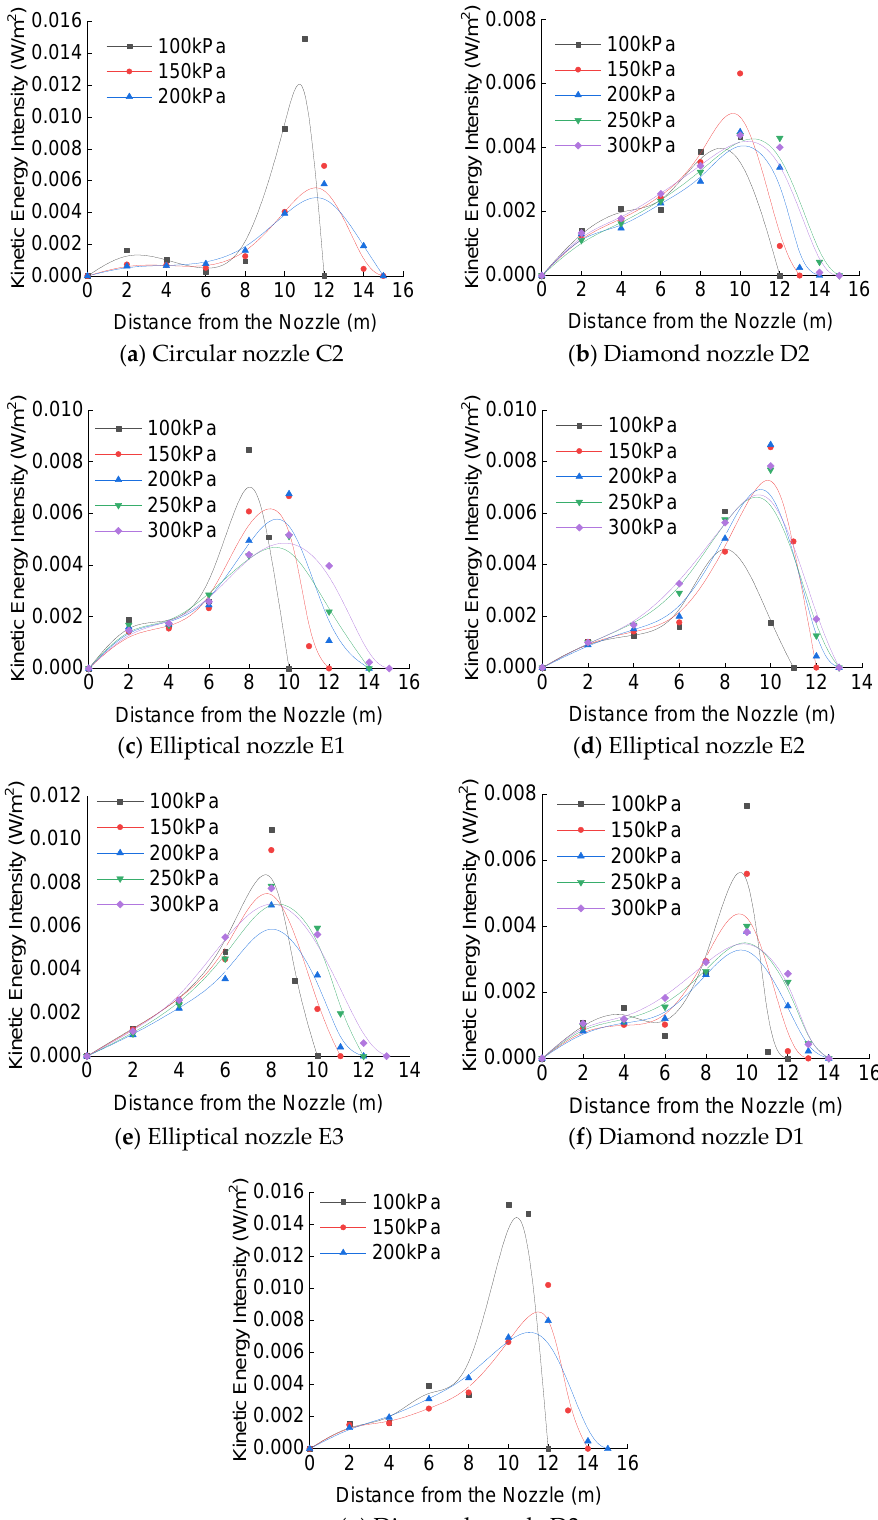
Figure 11. Kinetic energy intensity of the different single nozzles as a function of the distance from the nozzle under different working pressure levels. (C2 refers to the circular nozzle with a diameter of 5 mm; D1, D2, and D3 refer to the diamond nozzles with aspect ratios of 1.54, 1.32, and 1.11, respectively; E1, E2, and E3 refer to the elliptic nozzles with aspect ratios of 1.43, 2, and 2.58, respectively).